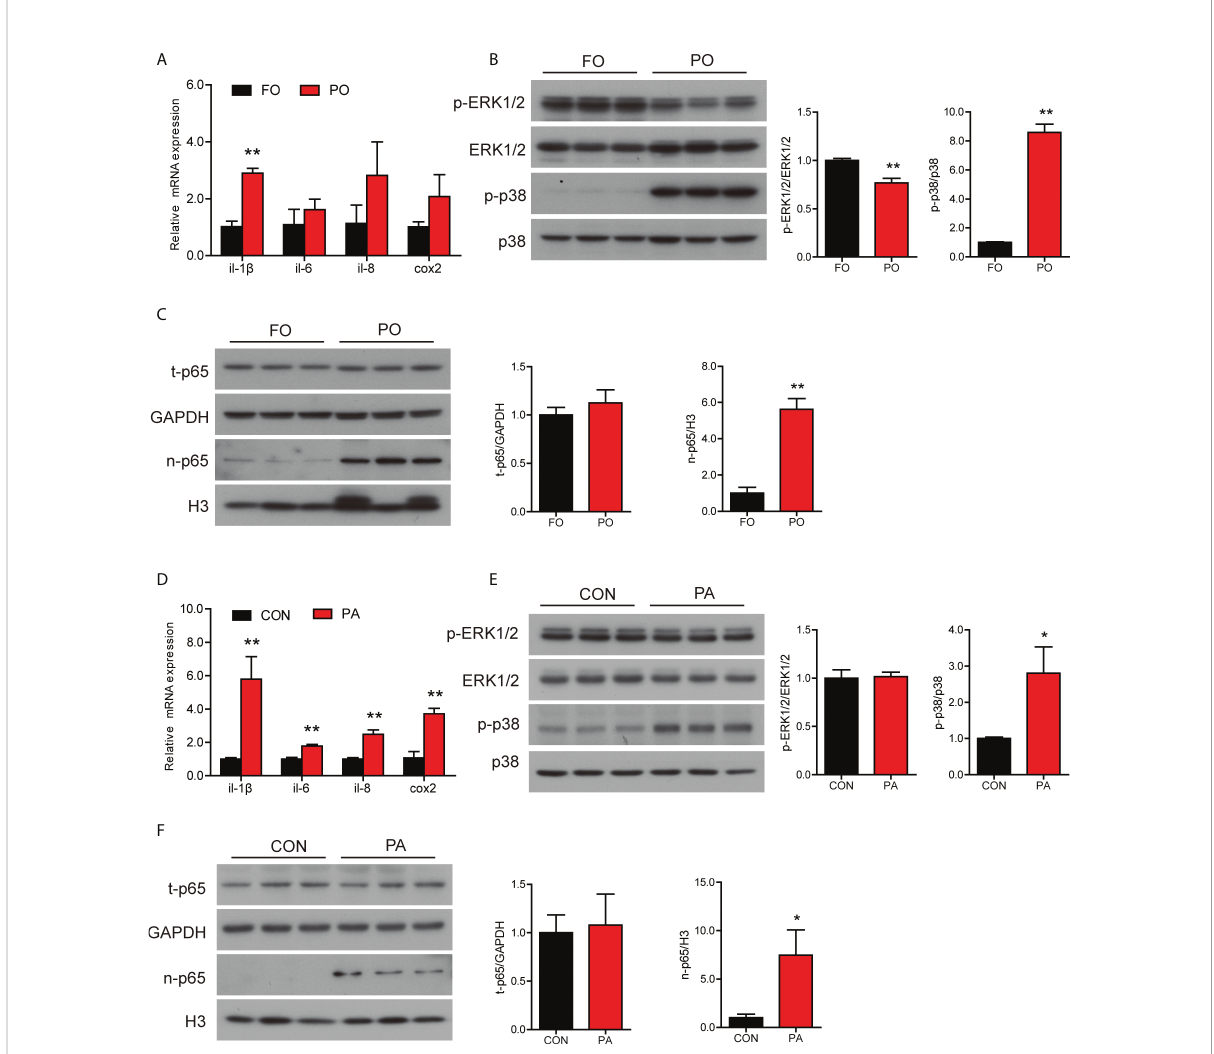
FIGURE 3 Effect of PO or PA treatment on in fl ammation in the intestine or intestinal cells of large yellow croaker. (A) Relative mRNA expression of proin fl ammatory genes in the intestine after different diets (n = 3). (B) Protein levels of p-ERK1/2, ERK1/2, p-p38 MAPK and p38 MAPK in the intestine after different diets (n = 3). (C) Protein levels of total p65 and nuclear p65 in the intestine after different diets. (D) Relative mRNA expression of proin fl ammatory genes in the intestinal cells after BSA or PA treatment (n = 3). (E) Protein levels of p-ERK1/2, ERK1/2, p-p38 MAPK and p38 MAPK in the intestinal cells after BSA or PA treatment (n = 3). (F) Protein levels of total p65 and nuclear p65 in the intestinal cells after BSA or PA treatment (n = 3). Results were presented as mean ± standard deviation (SD) and analyzed using independent t -test (* P < 0.05, ** P < 0.01). FO, fi sh oil; PO, palm oil; CON, bovine serum albumin treatment; PA, palmitic acid